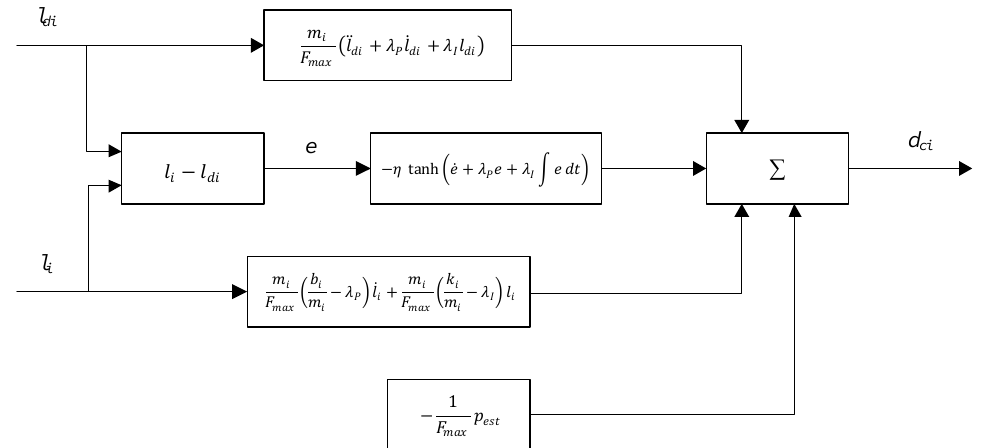
Figure 6. SMC scheme. The PMW outputs ( d ci ) are calculated with the actuators position feedbacks ( l i ) and the desired positions ( l di ) as inputs.